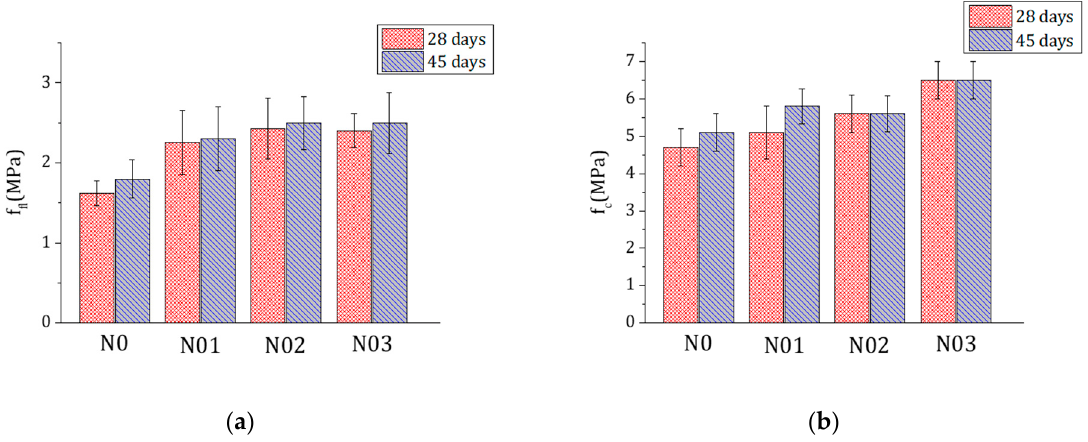
Figure 10. Flexural strength f fl ( a ) and compression strength f c ( b ) of samples with 0% (N0), 0.1% (N01), 0.2% (N02) and 0.3% FC (N03) at 28 d (red) and 45 d (blue).